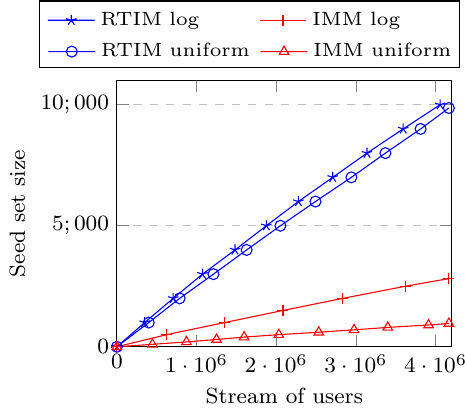
Fig. 8 Seed set size evolution with Twitter